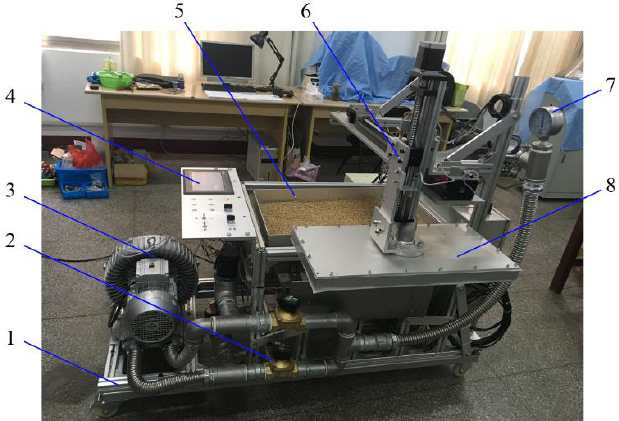
Figure 6. Vacuum plate seeder using rectangular vibrating tray: 1. Frame 2. Exchange valve 3. Fan 4. programmable logic controller (PLC) system 5. Seed tray 6. Cross-sliding table 7. Pressure gauge 8. Suction